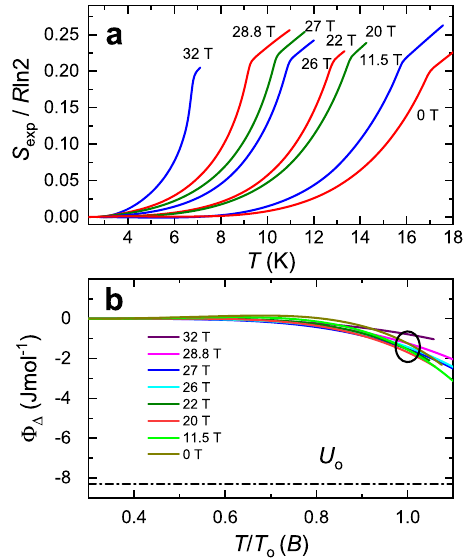
Fig. 3 Electronic entropy and free energy of quasiparticle excitations in URu 2 Si 2 . a The entropy divided by R ln2 (where R fi eld calculated using = k R B N A ) at different values of the magnetic 1 C exp d T where C exp refers to the measured heat capacity S exp ¼ 0 T after subtracting the phonon contribution and γ HO (see Methods). The entropy is similar to that previously obtained 4,5 . b Φ Δ calculated from the experimental heat capacity data of URu 2 Si 2 using Eq. (2) as described in the Methods at different magnetic fi elds as indicated. The horizontal axis is the temperature T divided by the observed transition temperature T o ( B ) at each magnetic fi